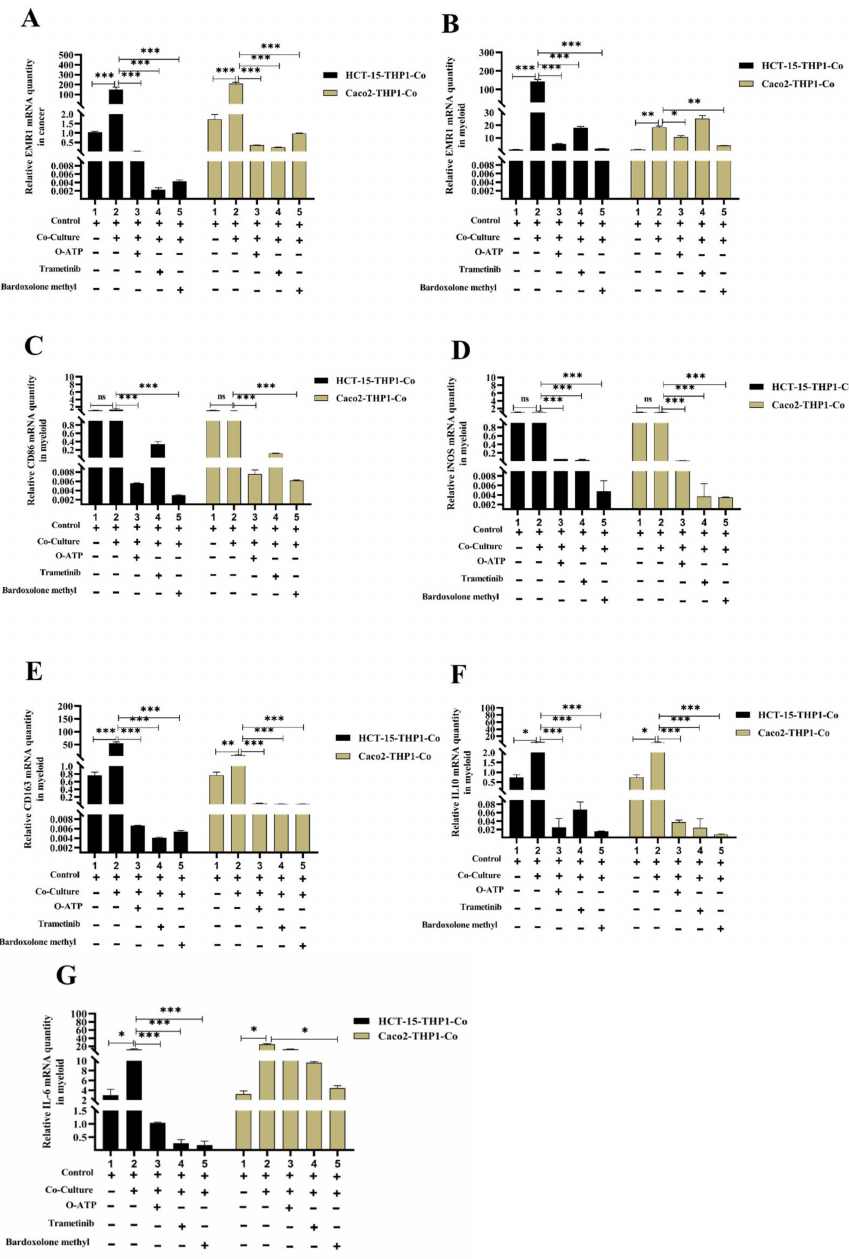
Figure 5. High EMR1 expression in cancer cells was correlated with M2 macrophage polarization in colon cancer. ( A , B ) Relative EMR1 mRNA level was detected in both CCs (HCT15, Caco2) and THP1-monocyte portion after being co-cultured with or without M2 macrophage inhibitors (O-ATP, Trametinib, and Bardoxolone methyl) for 48 h, as determined by real-time quantitative reverse transcription polymerase chain reaction; ( C , D ) Relative mRNA level of M1 macrophage markers (CD86 and iNOS), ( E ) M2 macrophage marker CD163, and ( F , G ) Cytokines interleukin (IL)-10 and IL-6 were detected in THP1-monocyte portion after being co-cultured with or without M2 macrophage inhibitors. Results were normalized by GAPDH. Error bars denote standard deviation. The results are representative of three independent experiments. * Statistically significant at * p < 0.033; ** p < 0.002; *** p < 0.001 in comparison with the control as well as co-cultured group by multiple Bonferroni two-way ANOVA group